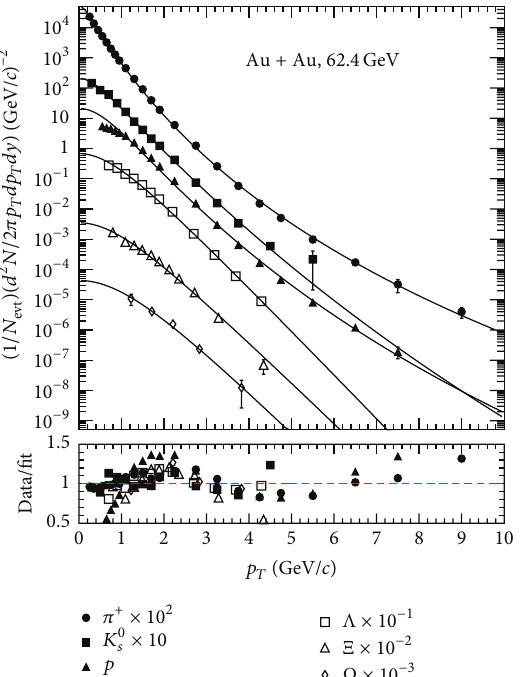
Figure 3: The data are from [30, 44] for Au + Au at √𝑠 𝑁𝑁 = 62 . 4 GeV. The curves are the analytical results with Tsallis distribu- tion Equation (10). The corresponding fitting parameters and 𝜒 2 /ndf are given in Table 1. For a better visualization both the data and the analytical curves have been scaled by a constant as indicated. The ratios of data/fit are shown at the bottom (Color